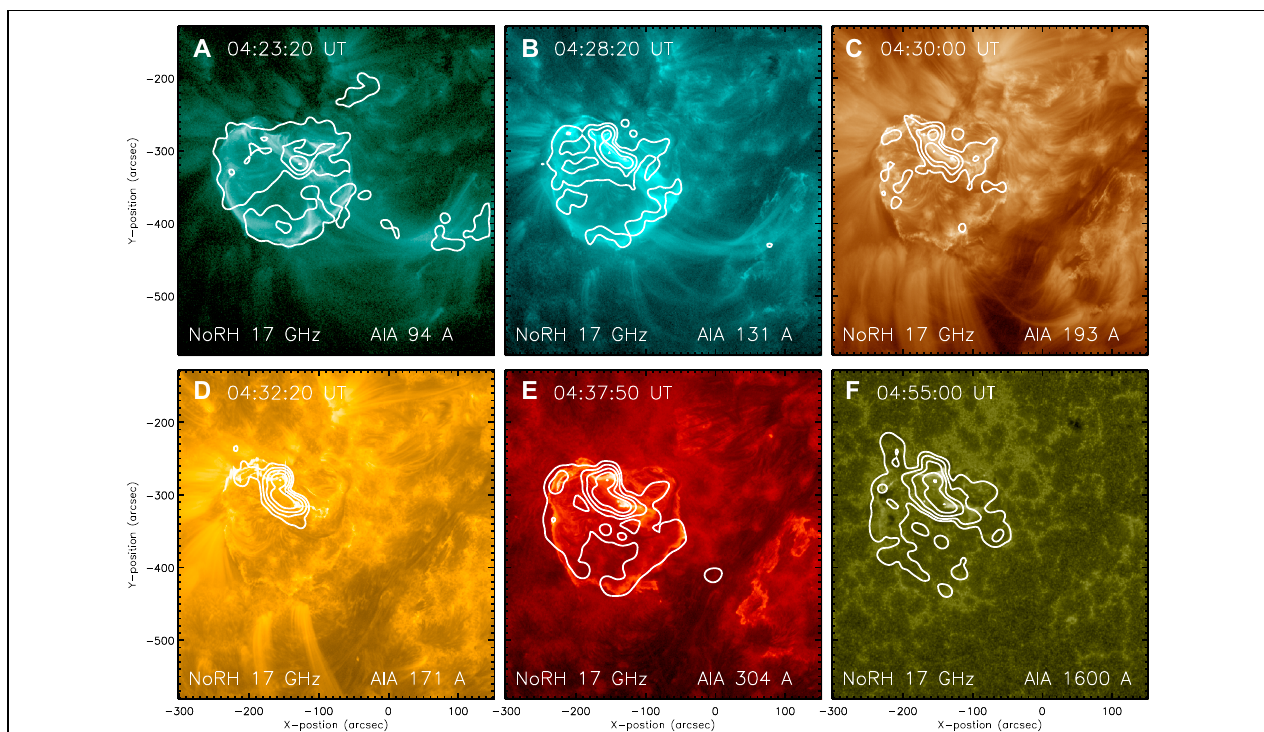
FIGURE 1 | Microwave and (E)UV emissions of the CRF. The flare occurred at 04:51 UT on 2014-12-17 from NOAA AR 12242. Microwave sources evolving from the preflare phase (A–C) to the impulsive phase (D) and the postflare phase (D,F) are shown as contours over the AIA (E)UV images in the six channels at the corresponding times. Contour levels in the top panels are at [1.9, 7.0, 26.99]% of the maximum in each frame, and those in the bottom panels are at [0.5, 1.9, 7.0, 26.99]% of each maximum. (Source: Lee et al.,